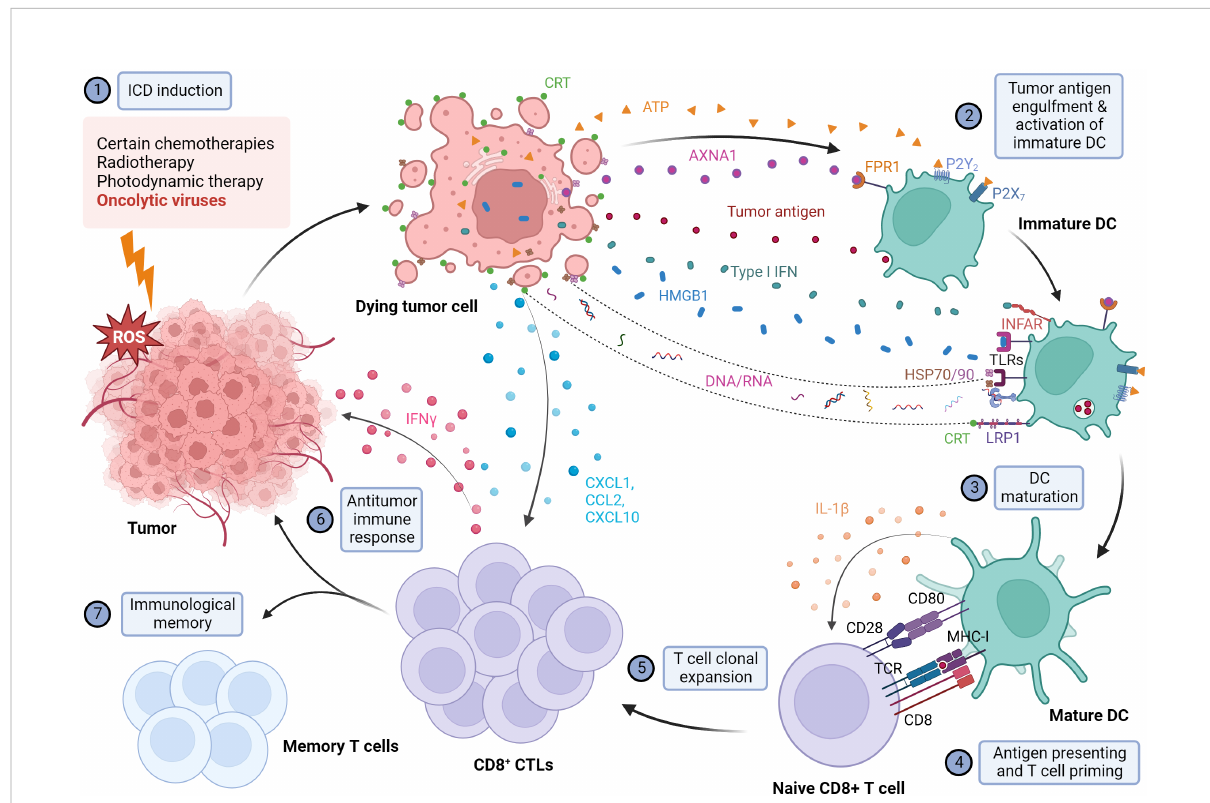
FIGURE 1 Illustration of the mechanism of immunogenic cell death and the subsequent activation of the antitumor immune response. When exposed to different immunogenic cell death (ICD) inducers, including OVs, cancer cells are under extreme ER stress and undergo ICD. Dying cancer cells express various damage-associated molecular patterns (DAMPs), including the release of high mobility group box 1 (HMGB1) from the nucleus, translocation and cell surface exposure of calreticulin (ecto-CRT) and heat shock proteins HSP70/90, and extracellular secretion of ATP, Annexin A1 (AXNA1), cytokines, chemokines, and nucleic acids. Exposure to DAMPs serves as a " fi nd me" signal which recruits immature DC to TME and induces the maturation of DC. Ecto-CRT provides a pro-phagocytic signal that promotes the phagocytosis of antigens by DC. In addition, HMGB1 and HSP70/90 assist in promoting the processing of phagocytic cargo by binding to toll-like receptors (TLRs), thereby escalating antigen engulfment, processing, and presentation to T cells to mediate tumor-speci fi c immune response and protective immunological memory. Created with